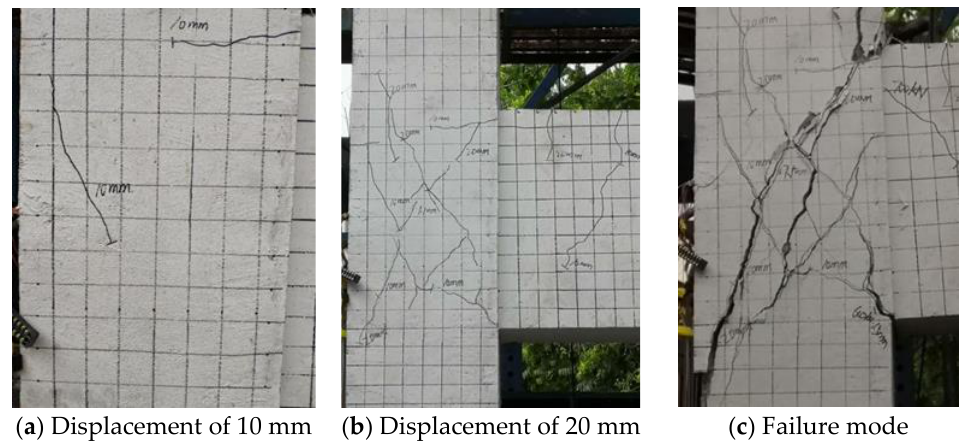
Figure 16. Crack development and failure of specimen BJ-1.